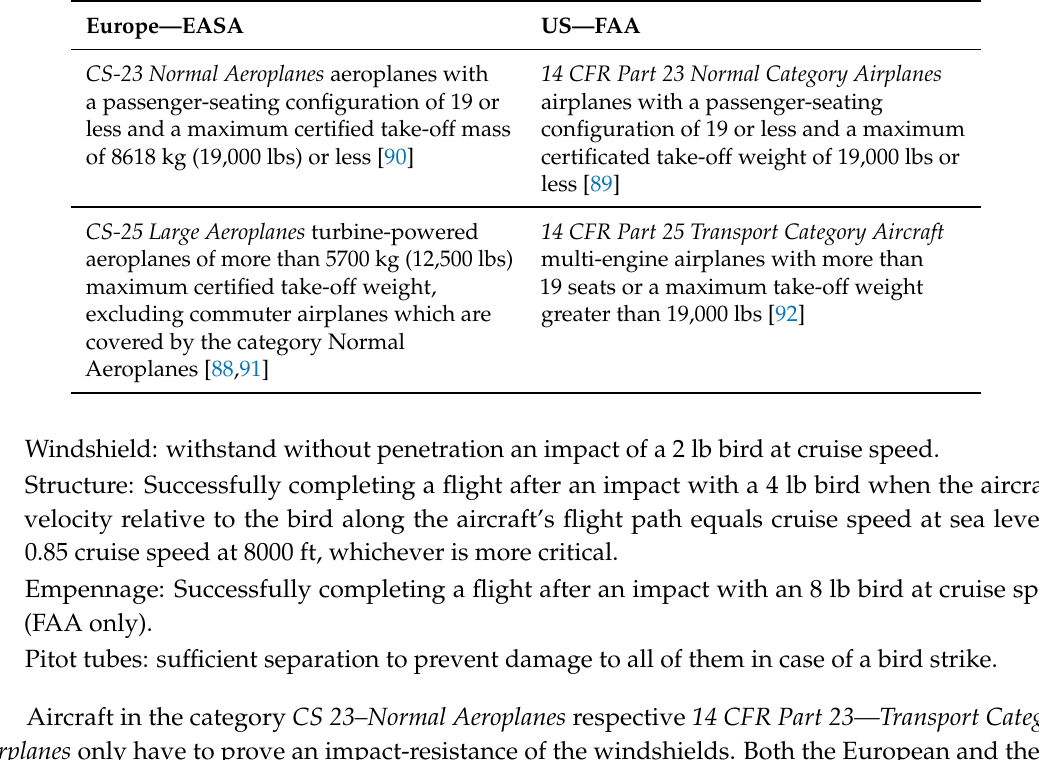
Table 5. Certification categories relevant for commercial aviation aircraft in Europe and the US (CS: Certification Specifications; CFR: Code of Federal